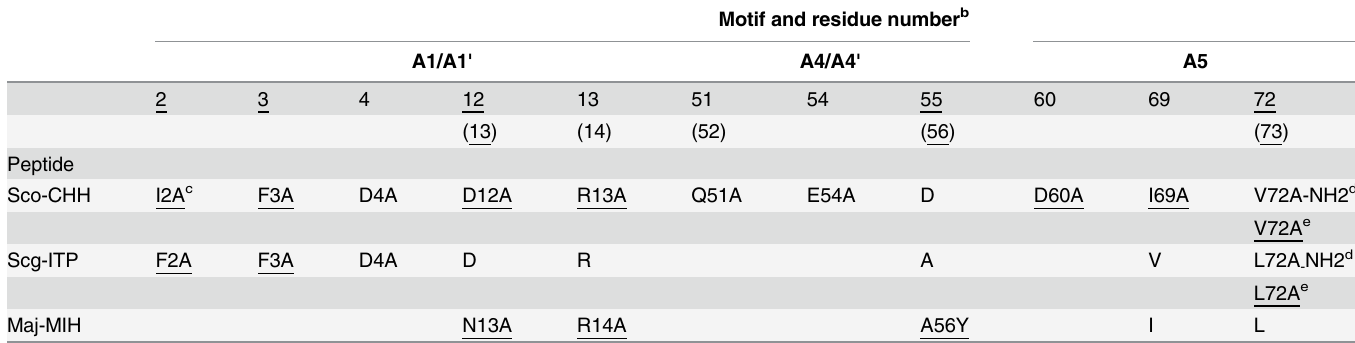
Table 2. Position and residue of CHH, ITP, MIH peptides which point-mutated peptides have been tested for importance in biological activity. a Motif and residue number